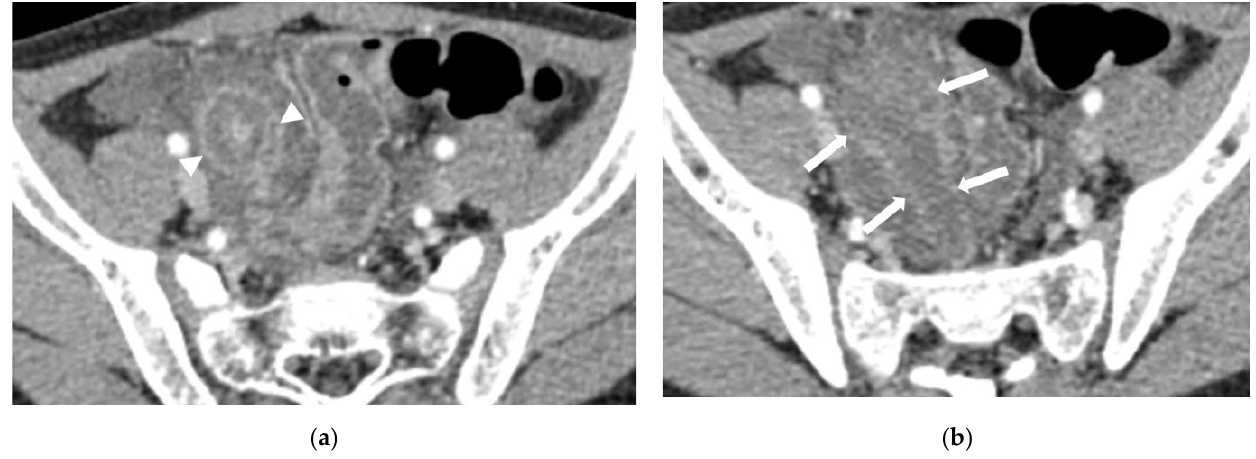
Figure 3. An 8-year-old male with pathologically confirmed complicated appendicitis. ( a ) Distended appendix is seen (arrowheads). ( b ) A 6 cm-sized discrete fluid collection with defined rim enhancement is present adjacent to distended appendix suggesting periappendiceal abscess (arrows).